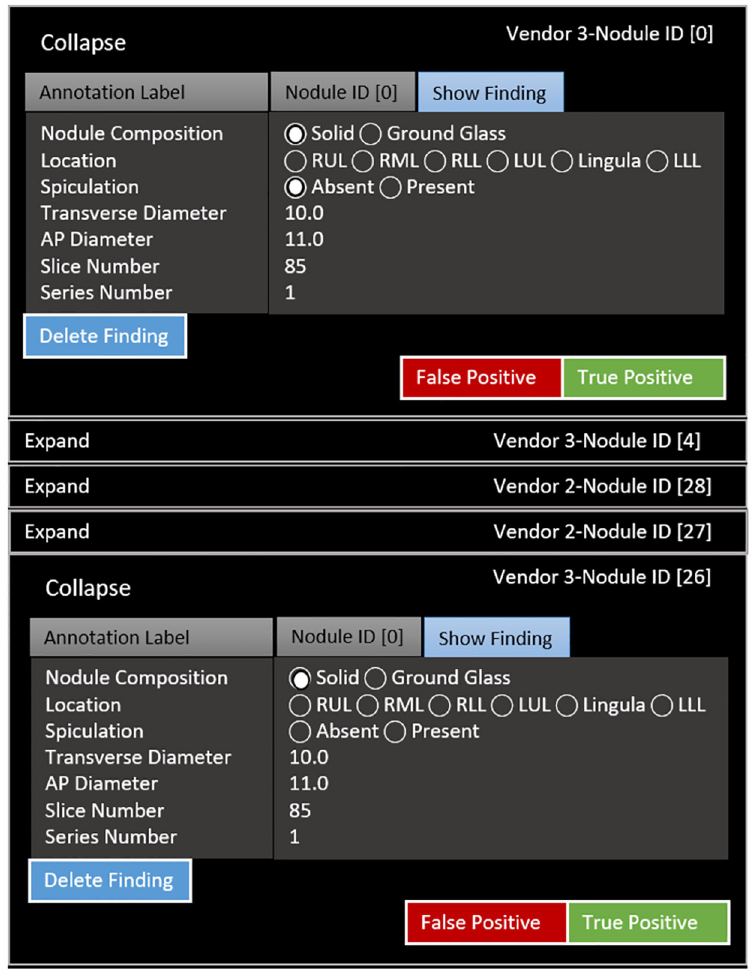
Fig 4. Algorithm evaluation results viewed using image annotation-visualization tool for comparison to ground- truth. Note patient protected health information (PHI) is changed for de-identification